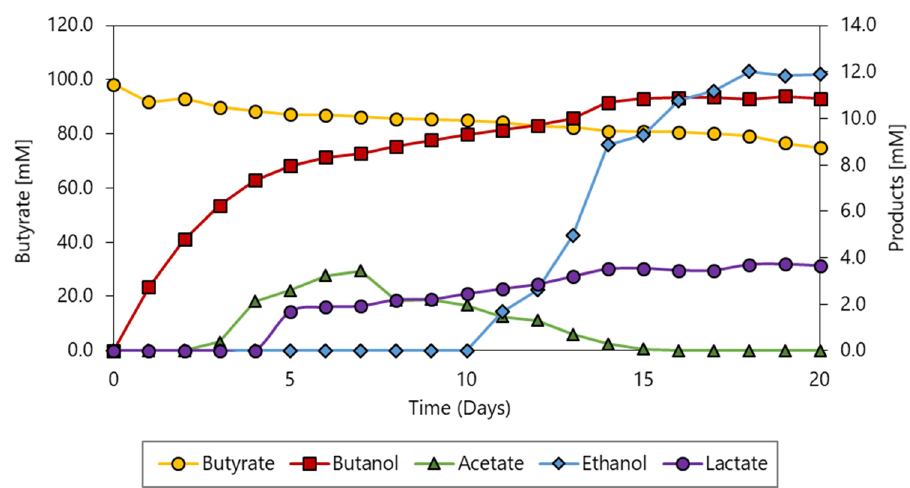
Figure 4. Measured concentrations of butyrate as substrate (primary y -axis) and products (secondary y -axis) with time in the controlled bioreactor.